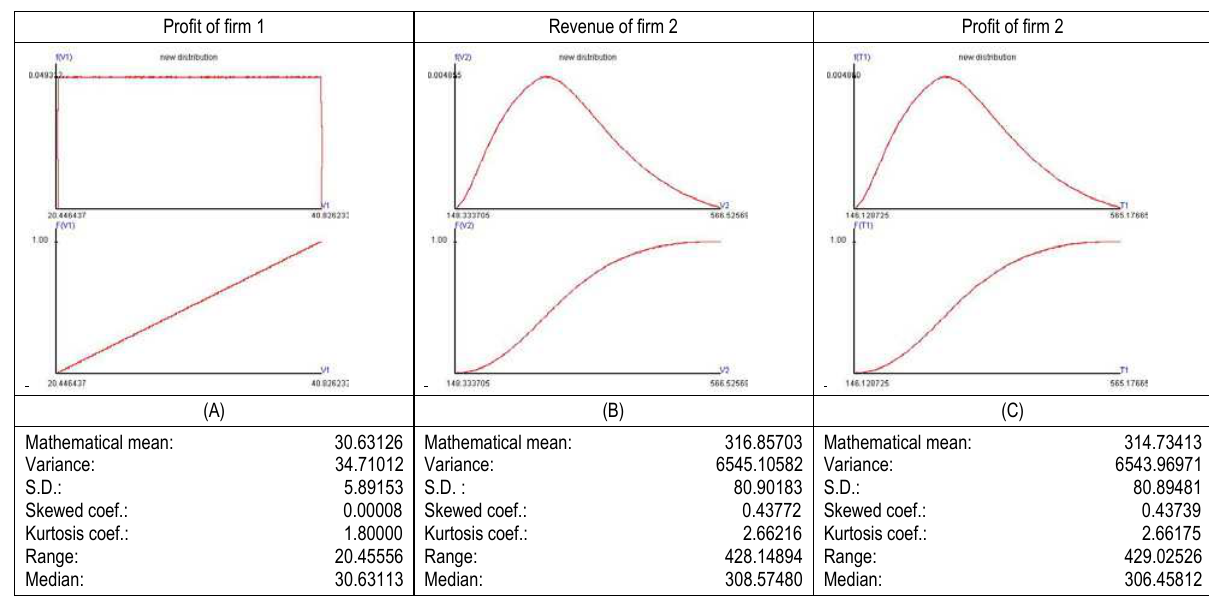
Table 4. Profits of firm 1 and firm